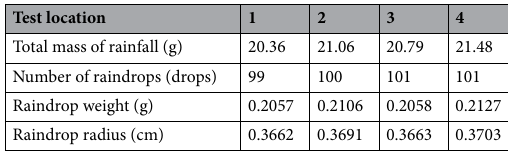
Table 2. Test data of the artificial rainfall simulator.